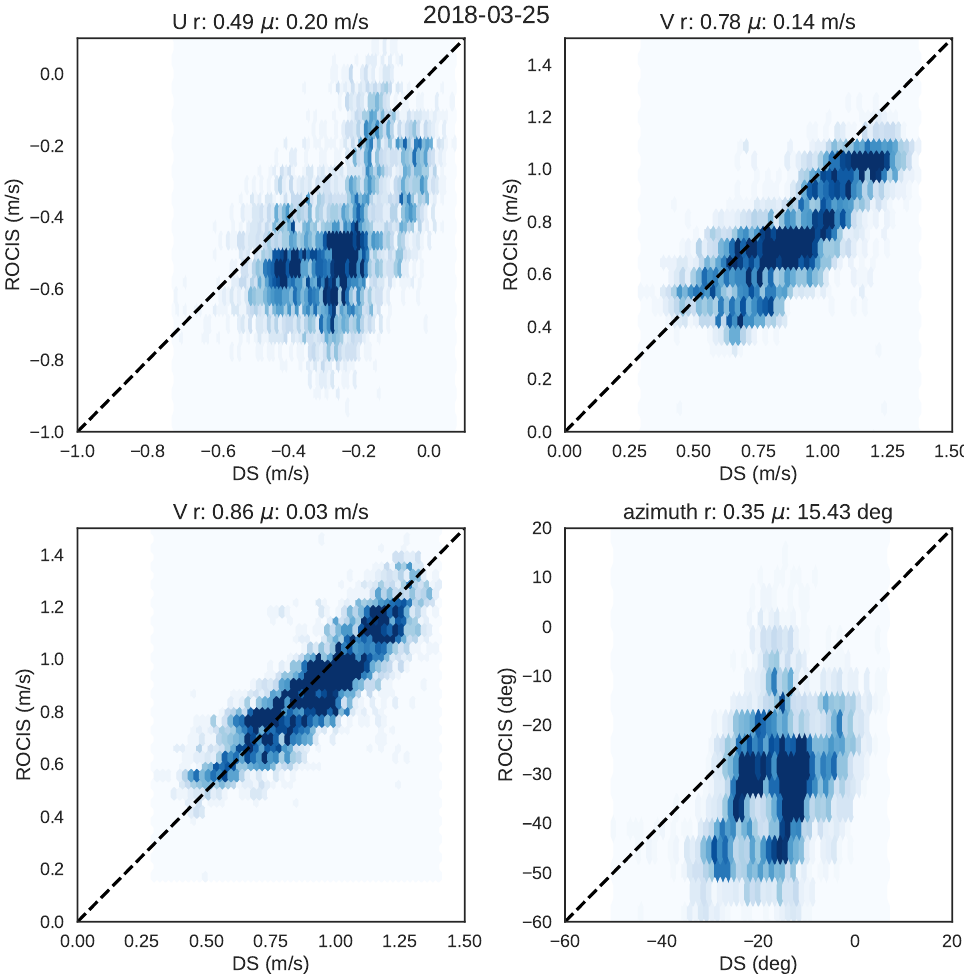
Figure 22. Hexbin scatterplot comparing DopplerScatt ( x -axis) versus ROCIS ( y -axis) measurements of U ( upper left ), V ( upper right ), speed ( lower left ), and azimuth direction relative to north ( lower right ). The Pearson correlation coefficient, r , and mean offset, µ , for each quantity is shown above the respective figure. Data for 25 March